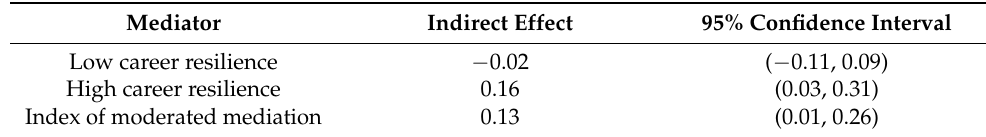
Table 5. Conditional indirect effect